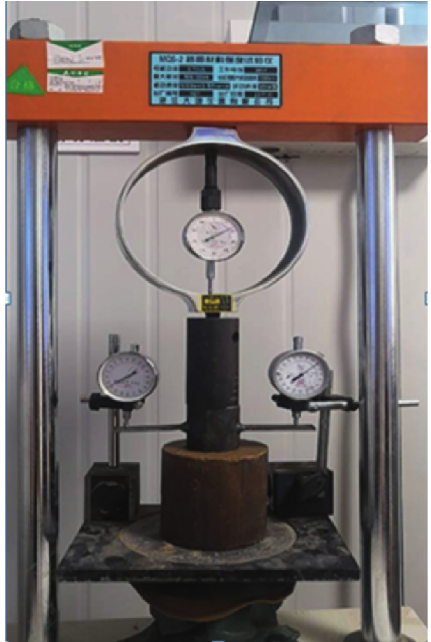
Figure 3: Photograph of resilient modulus test for